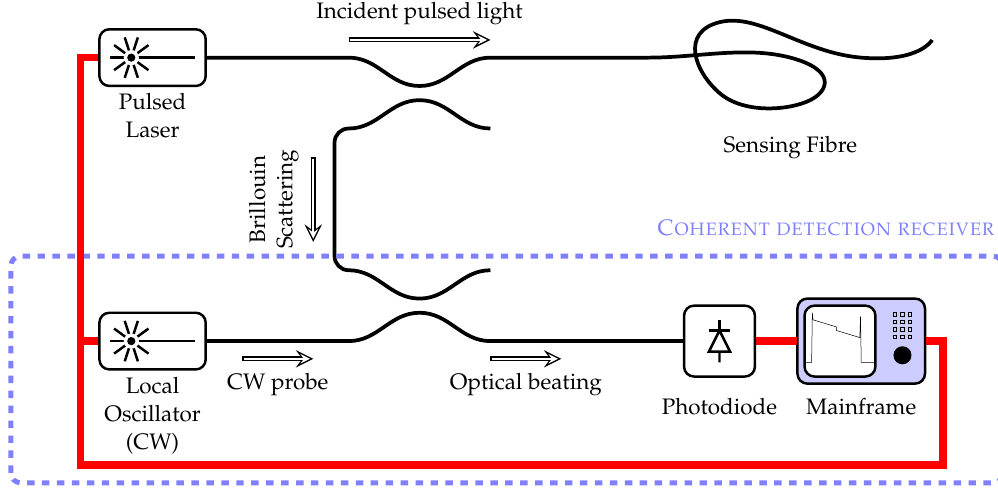
Figure 5. A typical configuration for a Brillouin optical time-domain reflectometer (BOTDR) system with coherent detection scheme (CW: continuous wave). After